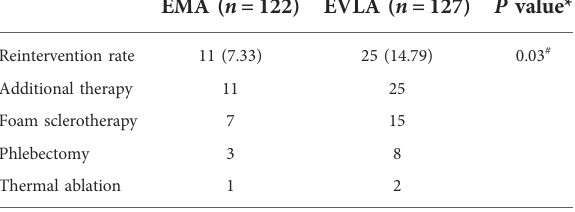
1 2 EMA, endovenous microwave ablation; EVLA, endovenous laser ablation; N , number. * P Value, EVLA compared with EMA. # P Value, compared with no. of